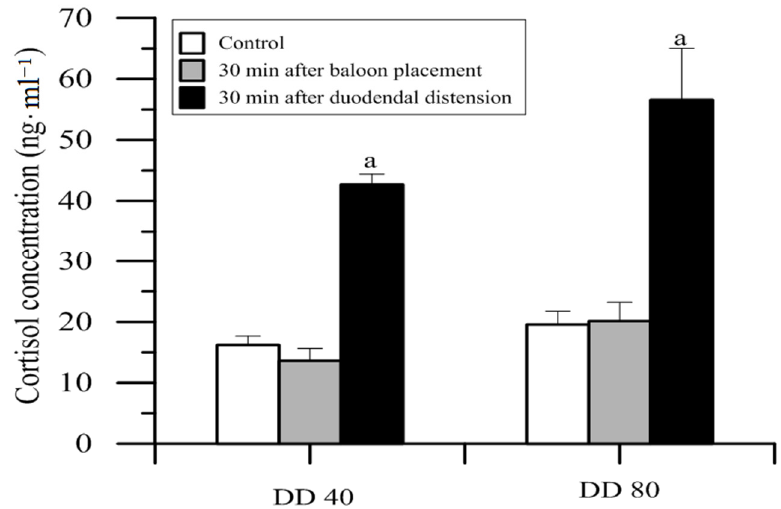
Figure 6. Effect of duodenal wall distension on cortisol concentration in sheep plasma in comparison to double control ( n = 6 ± SEM) [18]. DD40—distension by 40 mL of water; DD80—distension by 80 mL of water, a – statistically significant in relation to the previous groups